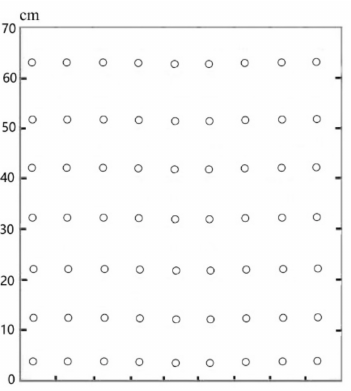
Figure 4. Diagram of coordinate transformation